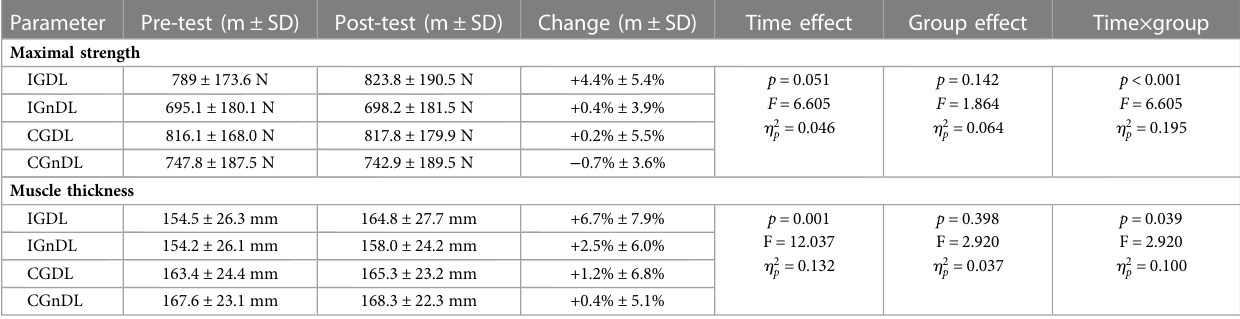
TABLE 3 Descriptive statistics and two-way ANOVA of maximal strength tests and muscle thickness.